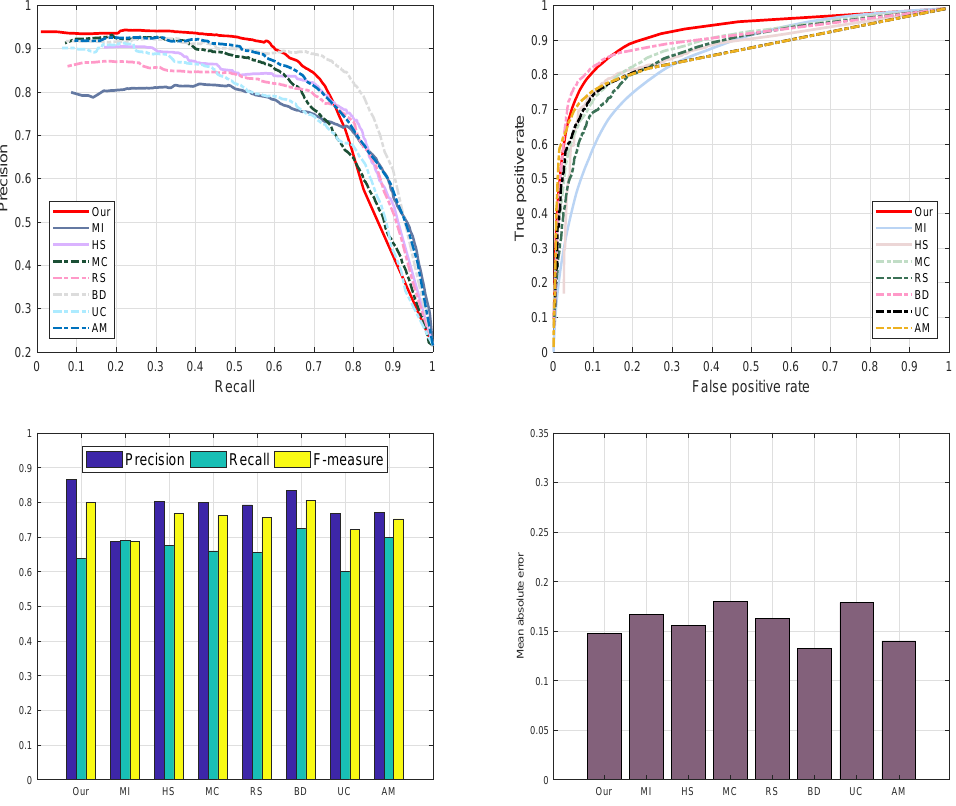
Figure 13. The graphical analysis of our SRD using four different saliency measures with other techniques.